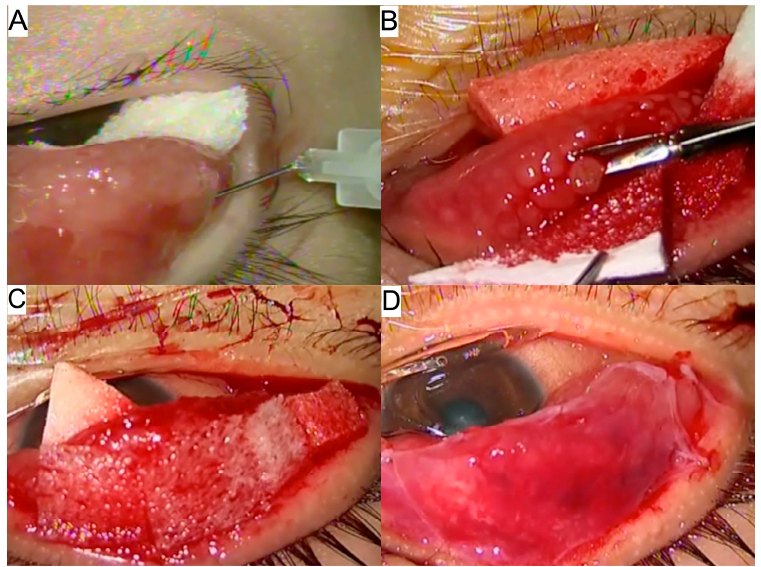
Figure 1. Surgical technique of giant papillary resection with Mitomycin C 0.02% and Amniotic membrane transplantation. ( A ) After everting upper eyelid, subconjunctival lignocaine and adren ‐ aline were injected at the base of giant papillae. ( B ) Excision of giant papillae at the base was per ‐ formed with Wescott scissors. ( C ) Weck cell sponge soaked in MMC 0.02% was applied onto tarsus for 5 min. ( D ) Amniotic membrane was placed over the tarsal surface with fibrin glue and sutured with 10 ‐ 0 vicryl. Subconjunctival cefazolin, gentamicin, and dexamethasone were injected at the end of surgery and a bandage contact lens was applied to the eye. 4. Results This study included five eyes of four patients. All were male, with a mean age of 9.8 years (range 7 to 14 years) at presentation. Table 1 shows the patient demographics, pre ‐ operative and postoperative visual acuity, corneal complications, and follow ‐ up duration. Table 2 shows the type of surgeries performed in all patients. All had bilateral involve ‐ ment. Despite this, bilateral surgery for GP was required in only 1 patient. The surgery was uneventful in all cases. Figure 2A–E shows the preoperative and postoperative im ‐ ages of all patients. Postoperative follow ‐ up ranged from 59 to 77 months (median 66 months). Amongst the 4 eyes which underwent AMT with MMC, only 1 eye demonstrated papillary regrowth requiring repeat surgery after 15 weeks {Case 3 ‐ left eye}. 4 patients had best corrected visual acuity (BCVA) >/= 6/9.5. One patient had BCVA 6/15 at final follow ‐ up due to the presence of anterior corneal stromal scar and poor ocular surface {Case 2}. Case 1 had no exacerbation of symptoms in the right eye till the last follow ‐ up, which was 8 years after surgery. Case 2 developed an acute flare in the right eye 2 years after surgery, which subsided with 4 months of topical steroid (prednisolone acetate 1% eye drops) treatment in tapering doses. Later the patient was prescribed ciclosporin 0.5% eye drops 2 times/day and olopatadine 0.1% eye drops 2 times/day. The eye was quiescent for the last 3 years and 10 months. Case 3 developed an acute flare of VKC symptoms 4 years and 10 months after surgery in the right eye and 4 years and 7 months after repeat surgery in the left eye. He was given topical steroids (dexamethasone 0.1% eye drops) in tapering doses for 4 months in the right eye and 9 months in the left eye. Thereafter, he was placed on tacrolimus 0.03% ointment 2 times/day and olopatadine 0.1% eye drops 2 times/day for both eyes. The right and left eyes were quiescent for the last 9 months and 4 months, respectively. Case 4 developed steroid ‐ induced glaucoma and underwent tra ‐ beculectomy 3 months after surgery. He experienced an acute flare of VKC symptoms 1.5 years after surgery which subsided after 2 months with tapering doses of prednisolone